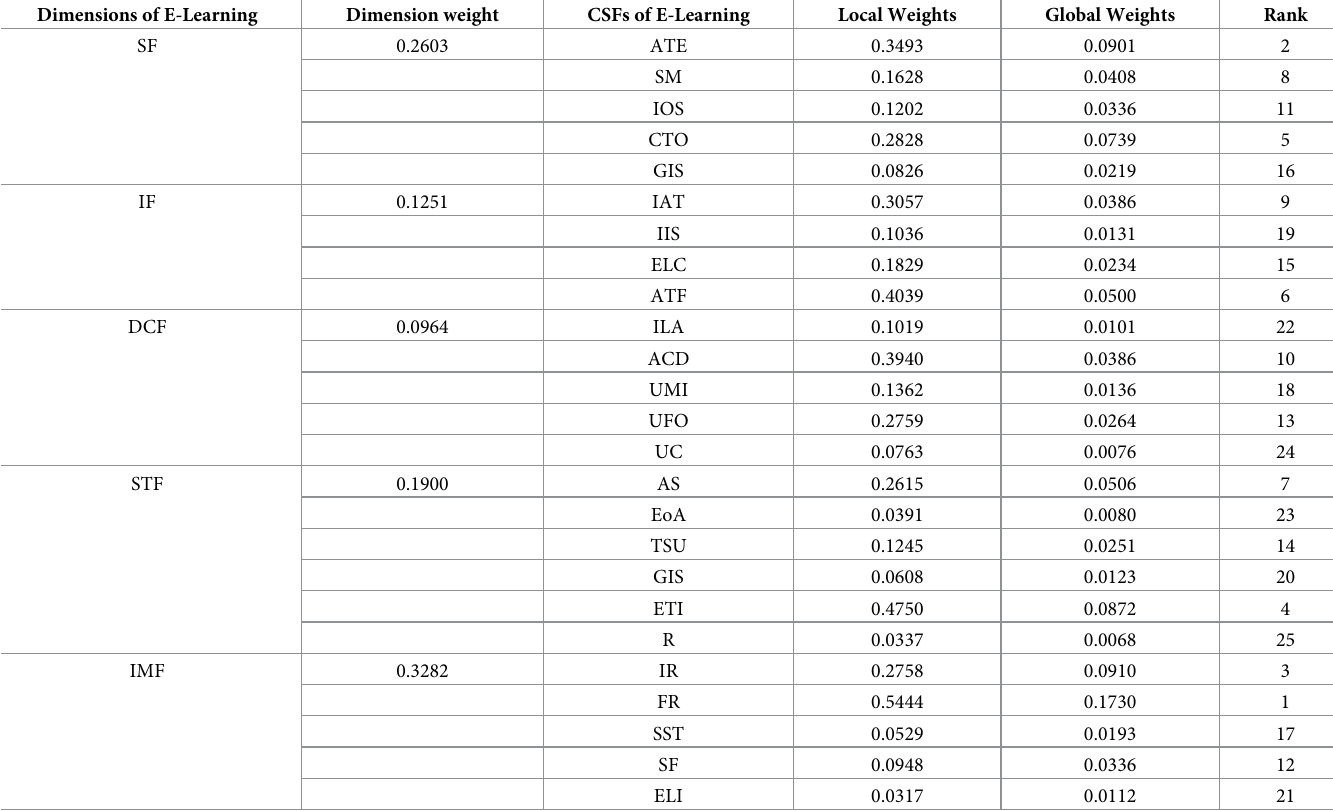
Table 9. Composite rank and weight of dimension and CSFs of E-Learning using AHP-GDM.